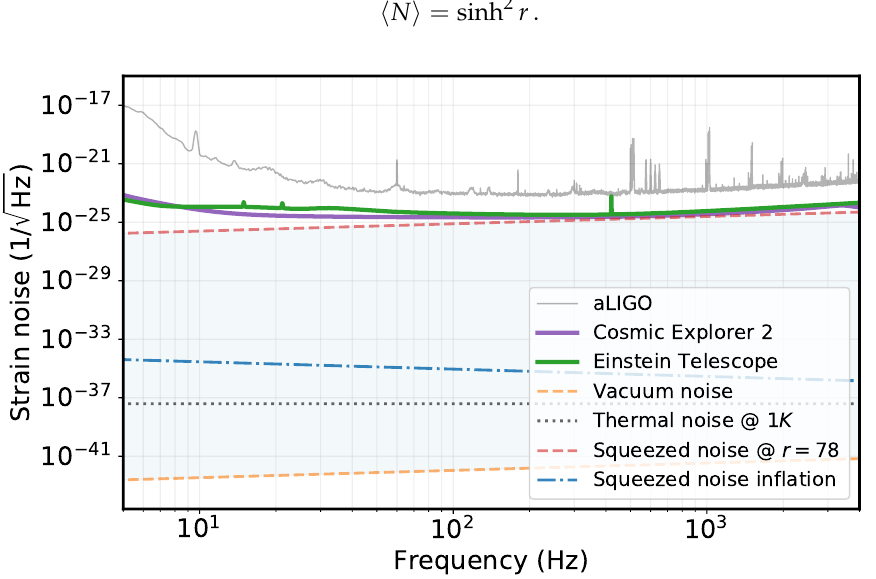
Figure 3. Strain plots for current and future GW detectors, and the predictions for fundamental strain fluctuations due to the gravitational vacuum, thermal, and squeezed gravitational